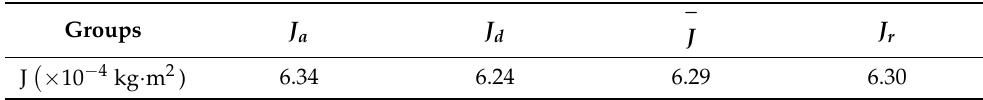
Table 7. Comparison of the calculation results.